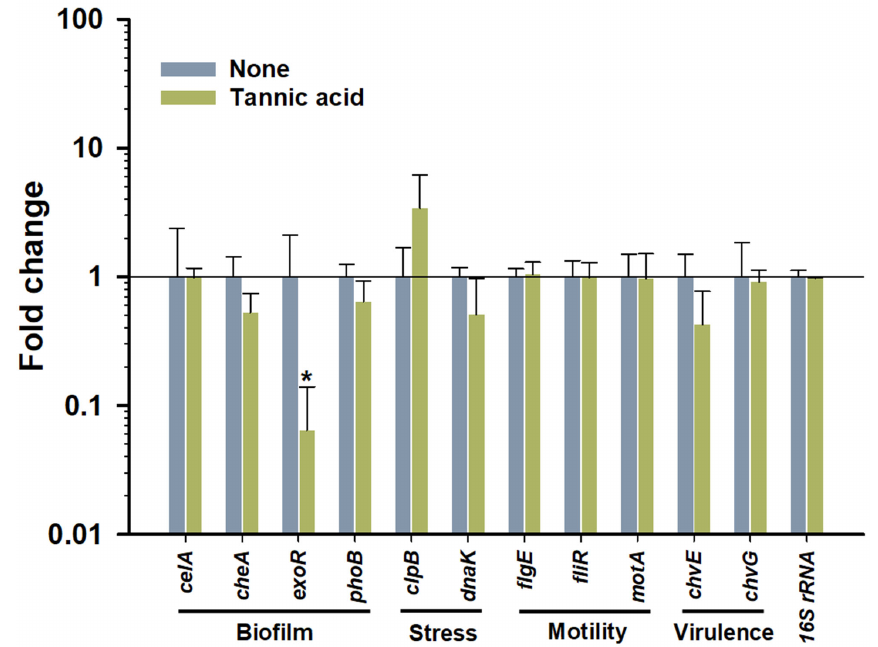
Figure 9. qRT ‐ PCR analysis of the expressions of genes after treating A. tumefaciens with tannic acid at 200 μ g/mL. The asterisk denotes a significant difference between nontreated and treated A. tume ‐ faciens . Two independent bacterial colonies were used in duplicates ( n = 4), and experiment was repeated twice. p ≤ 0.05 by the two ‐ tailed t ‐ test.